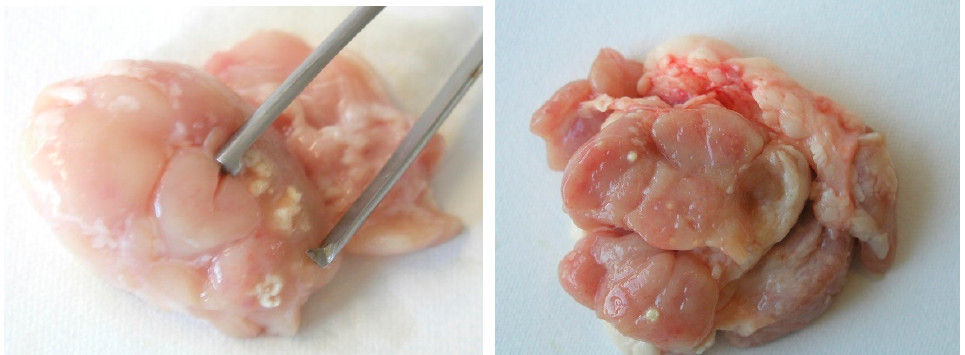
Figure 4. Tuberculous lesions in the mesenteric lymph ( left ) and head ( right ) nodes of domestic pig ( Sus scrofa f. domestica ) caused by M. avium ssp. hominissuis from peat used as feed supplements (Photo I. Pavlik).